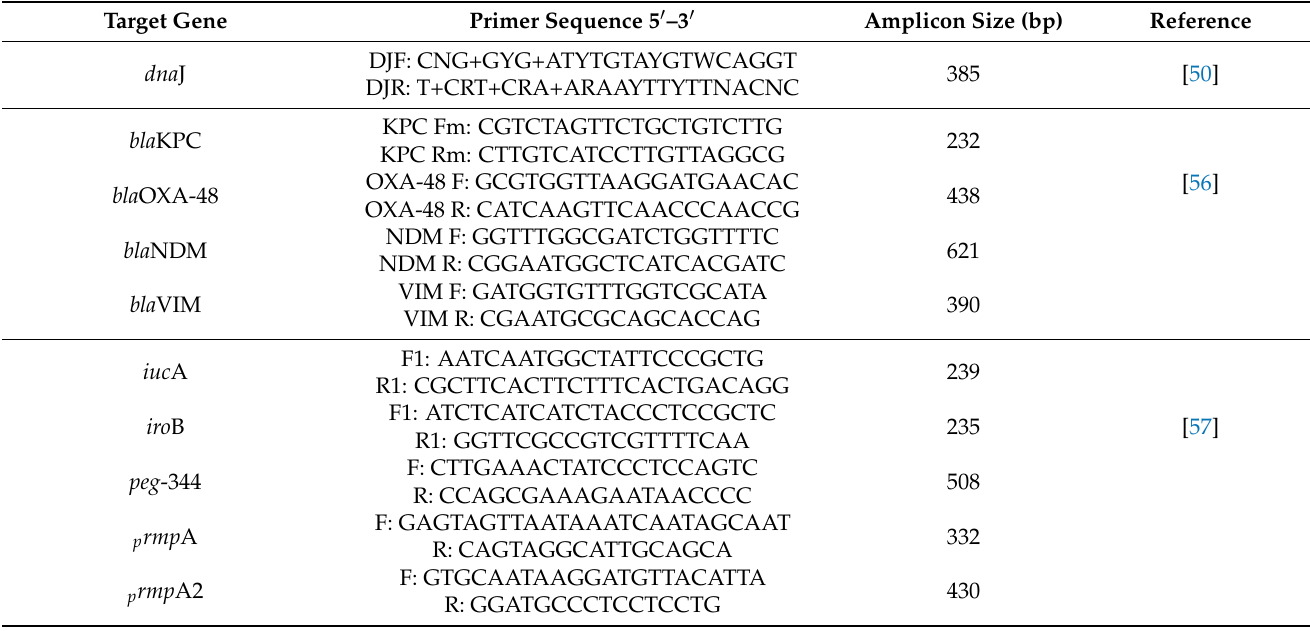
Table 3. Primer sequences of target genes for species molecular identification, carbapenemase-encoding genes, hyperviru- lence genes and their amplicon